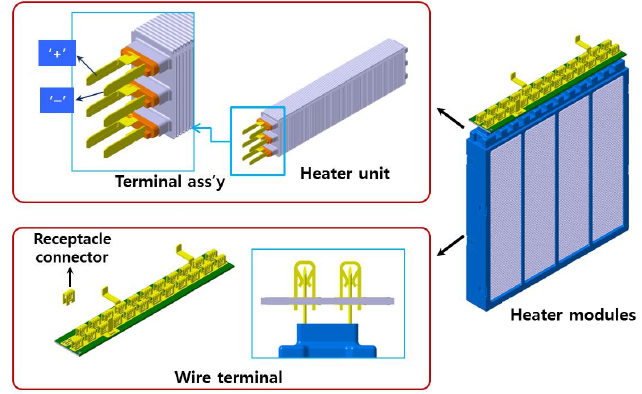
Figure 2. Schematic diagram of a heating rod. Energies 2016 , 9 4